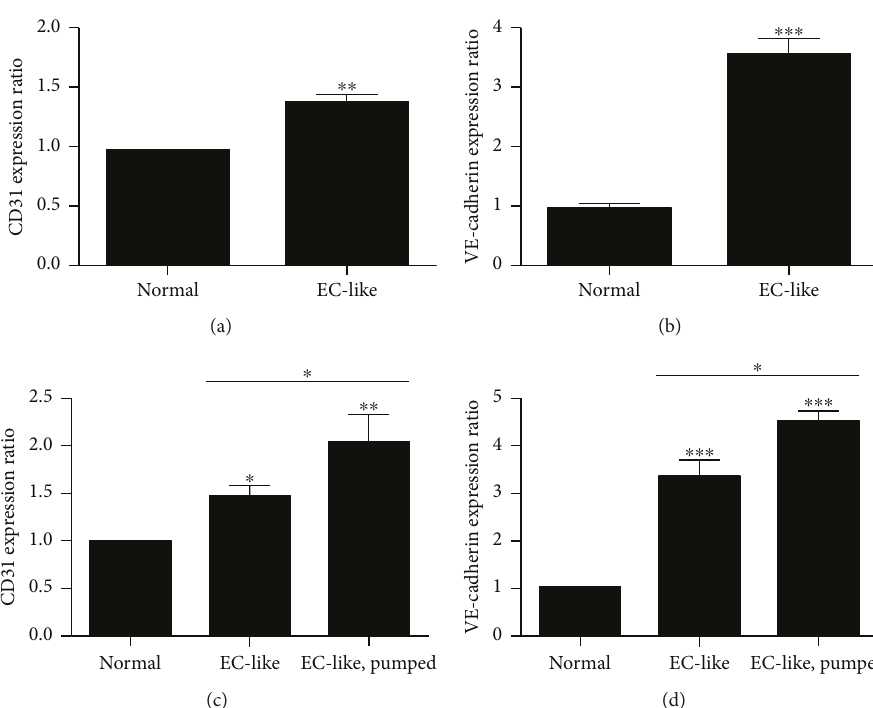
Figure 7: Vascular endothelial cell-related gene expression pro fi le by qRT-PCR. The mRNA expression levels of CD31 in cells (a) and tubes (c). The mRNA expression levels of VE-cadherin in cells (b) and tube (d). Error bars indicate the SD. ∗∗∗ P < 0 001 , ∗∗ P < 0 01 , and ∗ P < 0 05 .